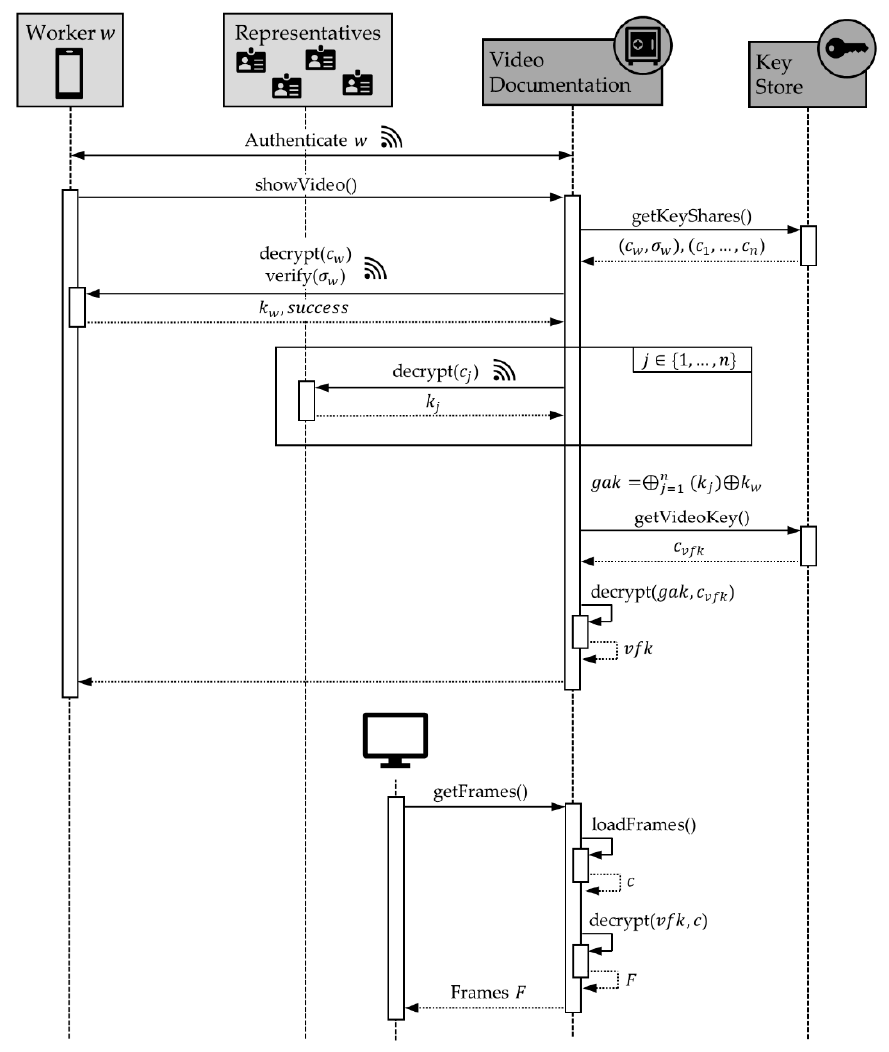
Figure 6. 4Crypt video decryption process.